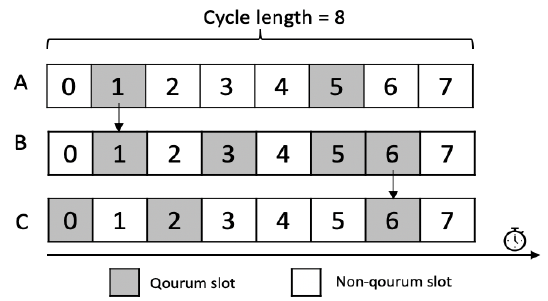
Figure 2. End-to-end delay in quorum-based scheduling.